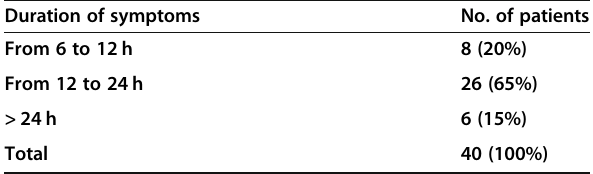
Table 3 Duration of symptoms before hospital admission Duration of symptoms No. of patients